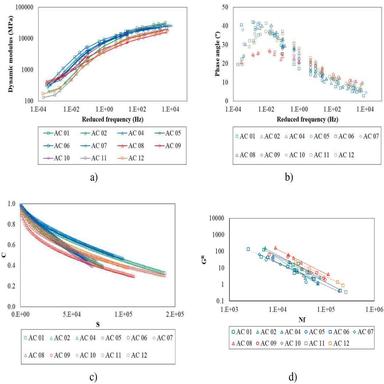
AC characterization of a) dynamic modulus master curves in log–log scale at 20 ◦C, b) phase angle master curves at 20 ◦C, c) fatigue damage C vs. S characteristic curves at 20 ◦C, and d) experimental GR vs. Nf failure envelopes.